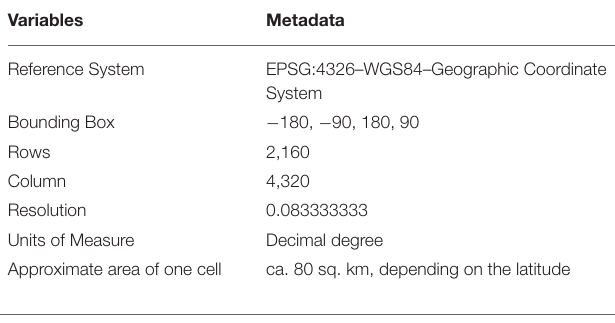
TABLE 3 | Data sources for country level calculation of